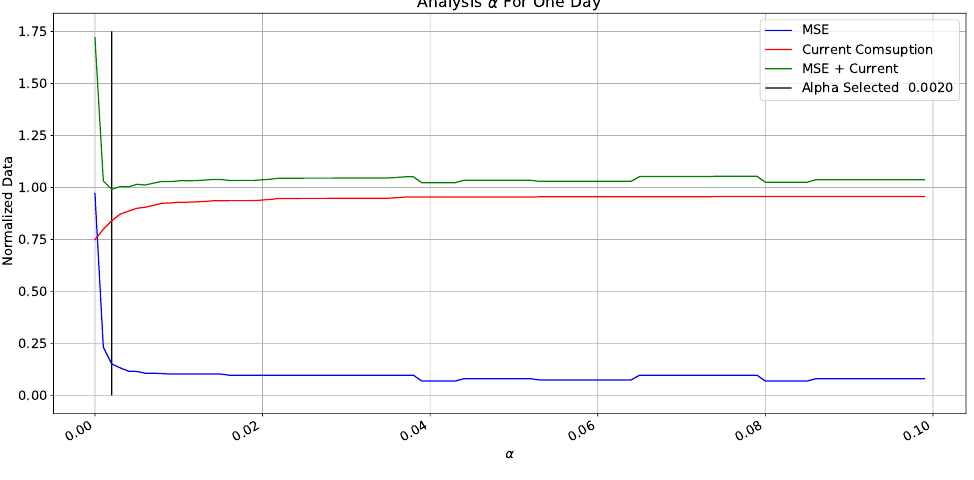
Figure 17. α analysis for one day.